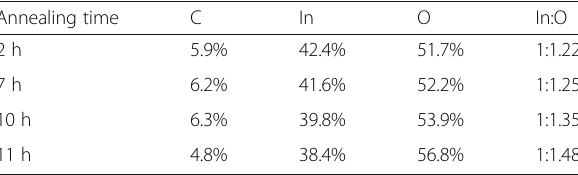
Table 3 The Elemental Percentages of In 2 O 3 Films Annealed